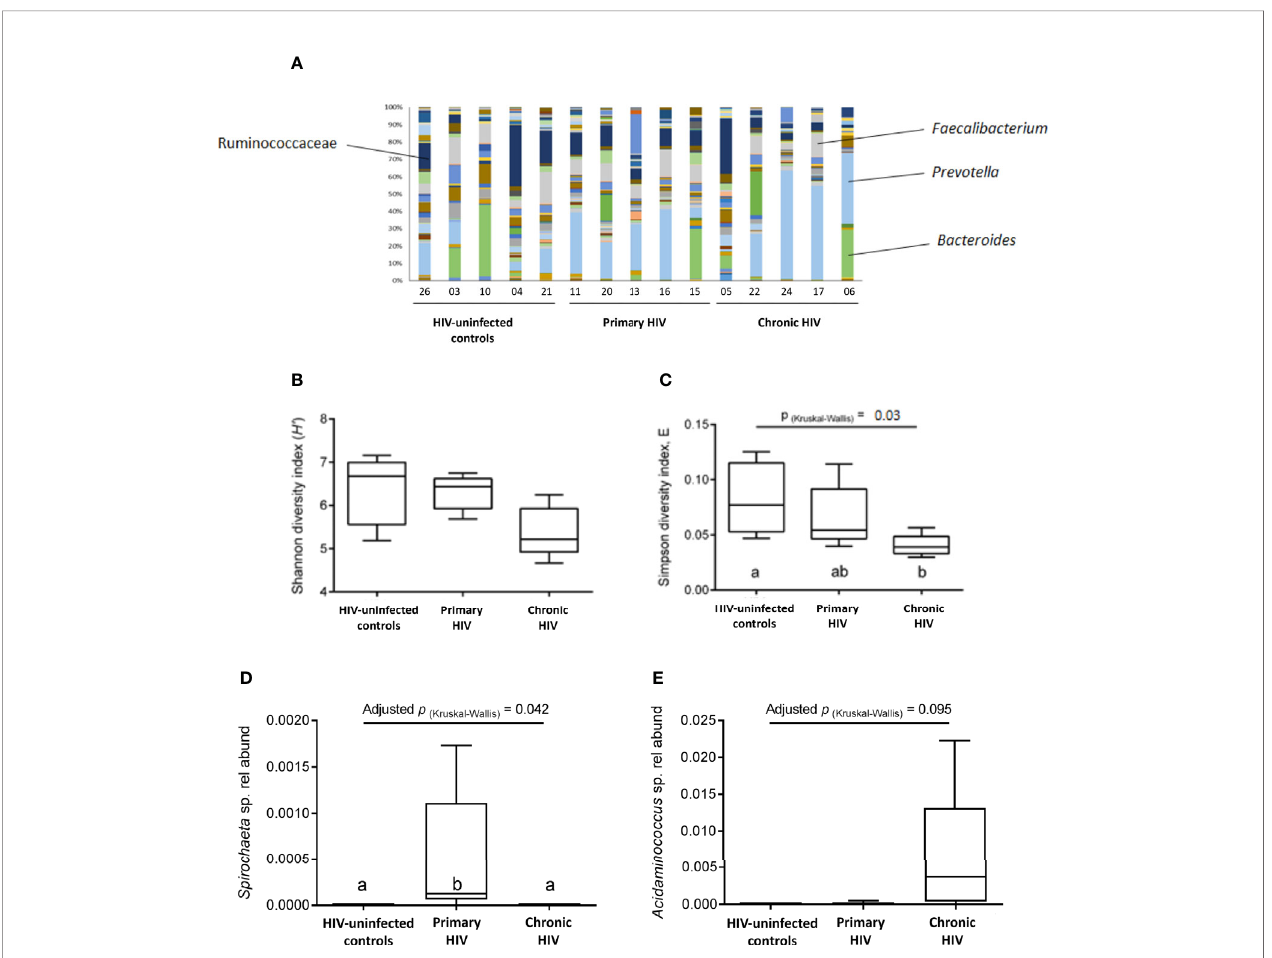
FIGURE 7 | Faecal microbiota composition. (A) Bacterial composition from analysis of faecal samples from study participants prior to bowel preparation. A total of 145 types of taxa are represented, with increased representation of fermentative taxa (i.e., Ruminococcaceae, Faecalibacterium, Prevotella, Bacteroides) compared to other taxa. (B) Species diversity and taxa distribution in study participants as measured by Shannon diversity index (H ’ ) (C) Species diversity and taxa distribution in study participants as measured by Simpson diversity index E (D) Relative abundance of the Spirochaeta genus between groups. (E) Relative abundance of the Acidaminococcus genus between groups.